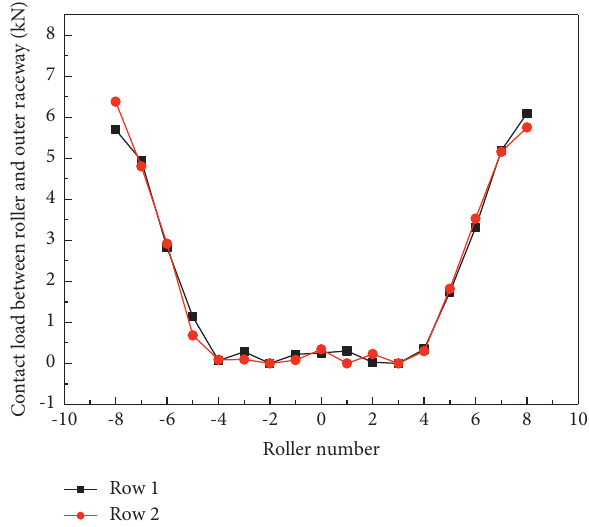
Figure 17: Instantaneous contact load (moment